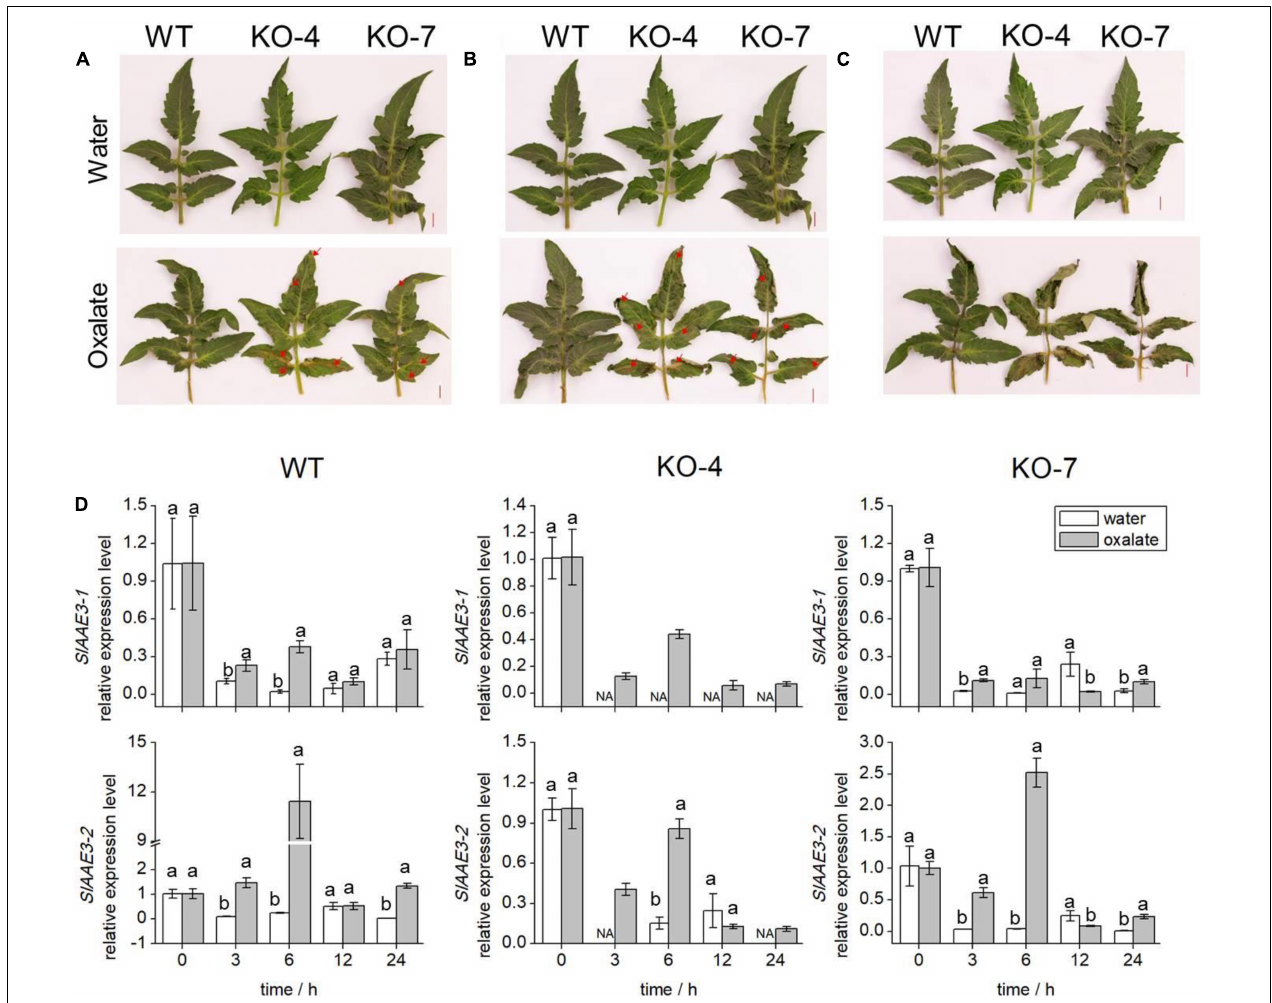
FIGURE 5 | Phenotypes and transcription analyses of WT and KO mutants. The comparison of oxalic acid (OA) sensitivity between WT and KO mutants with disabled SlAAE3-1. Excised leaves were dipped into the OA solution immediately, and negative control was kept in water. The detached leaves were photographed after (A) 24 h, (B) 30 h, and (C) 36 h. Brown lesion and shrink area were indicated by red arrows. (D) qRT-PCR analyses were carried out to reveal the expression level of SlAAE3-1 and SlAAE3-2 in the detached leaves. Error bars indicate mean values ± SD ( n = 3). Different letters on vertical bars indicate significant difference at p < 0.05 using one-way